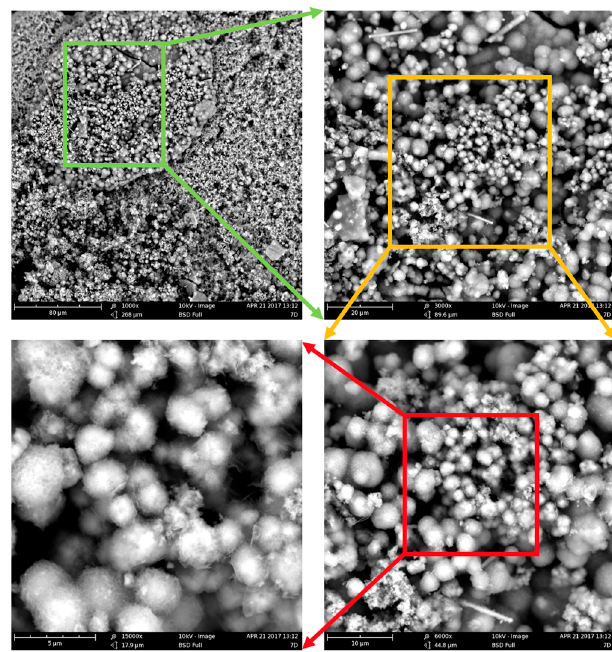
Figure 7. Spherical precipitates imaged with SEM with increasing magnification (1000×, 3000×, 6000×, and 15,000×).